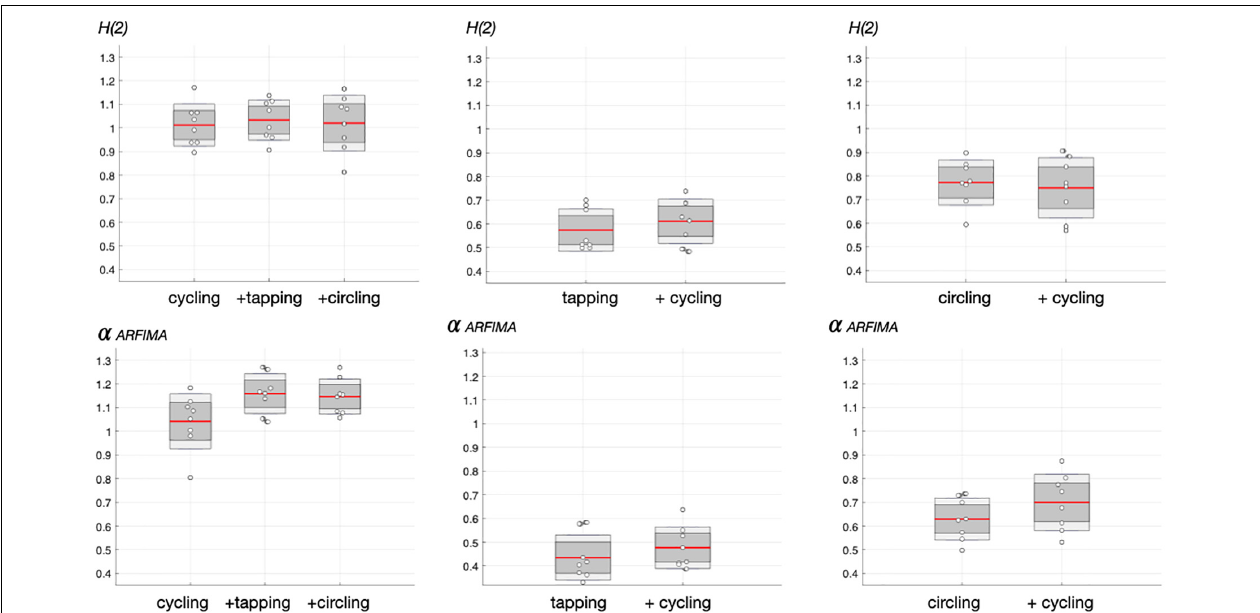
FIGURE 4 | Monofractal index. Values of the scaling (Hurst) exponent in time series assessed by FMF-DFA for q = 2,H(2) (top panels) and ARFIMA (bottom panels) . The central mark indicates the mean, dark gray the standard error to the mean (SEM) and light gray the standard deviation. Individual values are represented by “o” symbols.